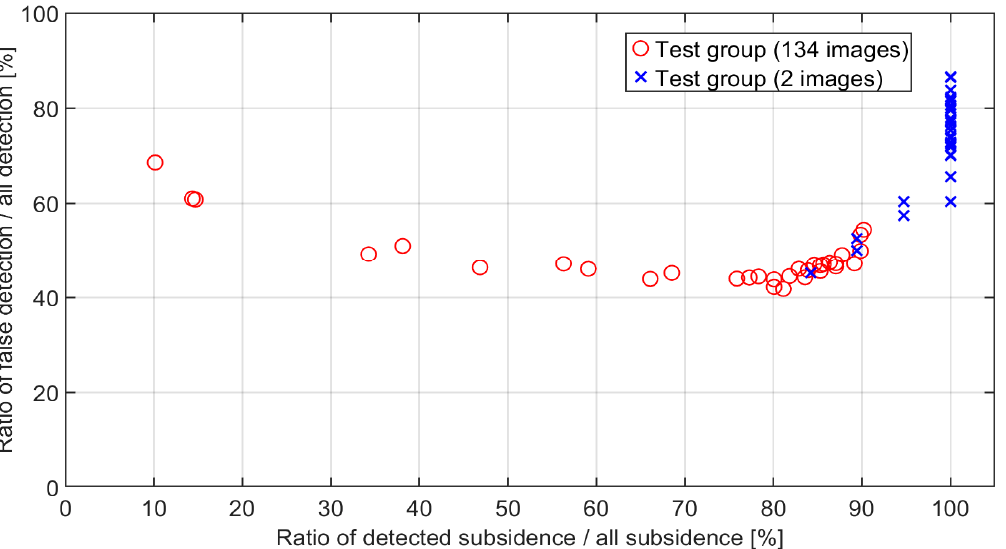
Figure 11. The comparison of the subsidence detection results for both test sets and all the parameter value combinations determining the algorithm efficiency.